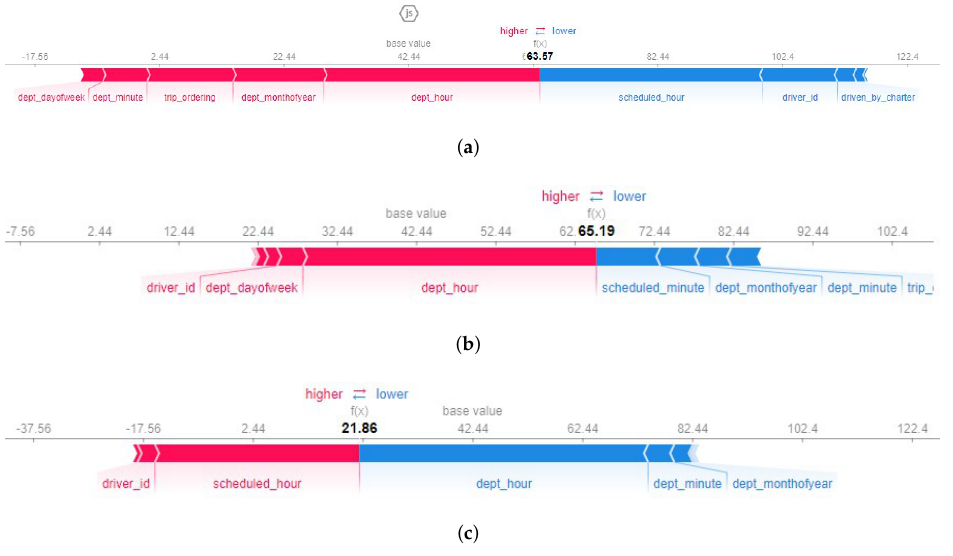
Figure 7. SHAP Force Plots for Explaining Three Prediction Instances. ( a ) Instance-1. ( b ) Instance-2. ( c ) Instance-3.